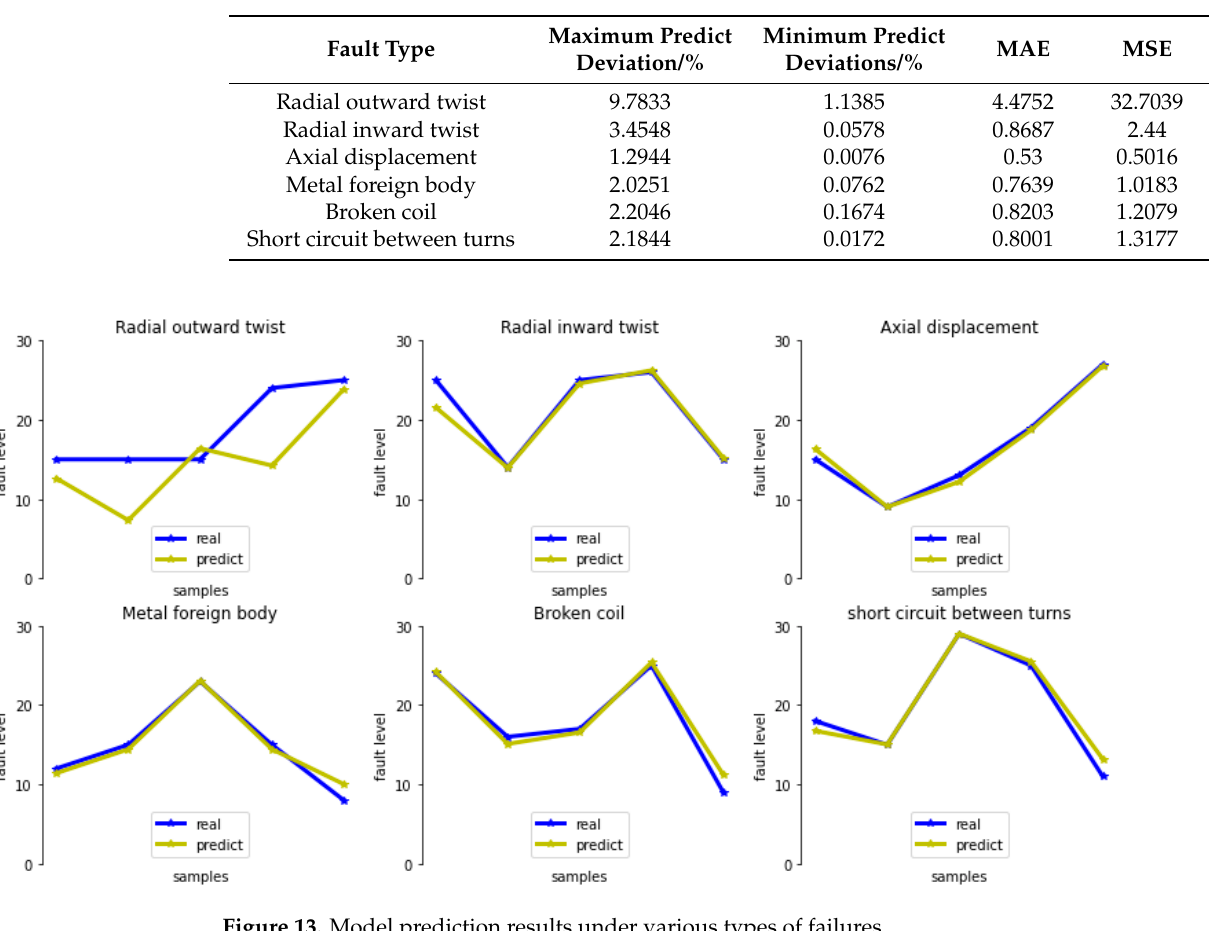
Figure 13. Model prediction results under various types of failures.